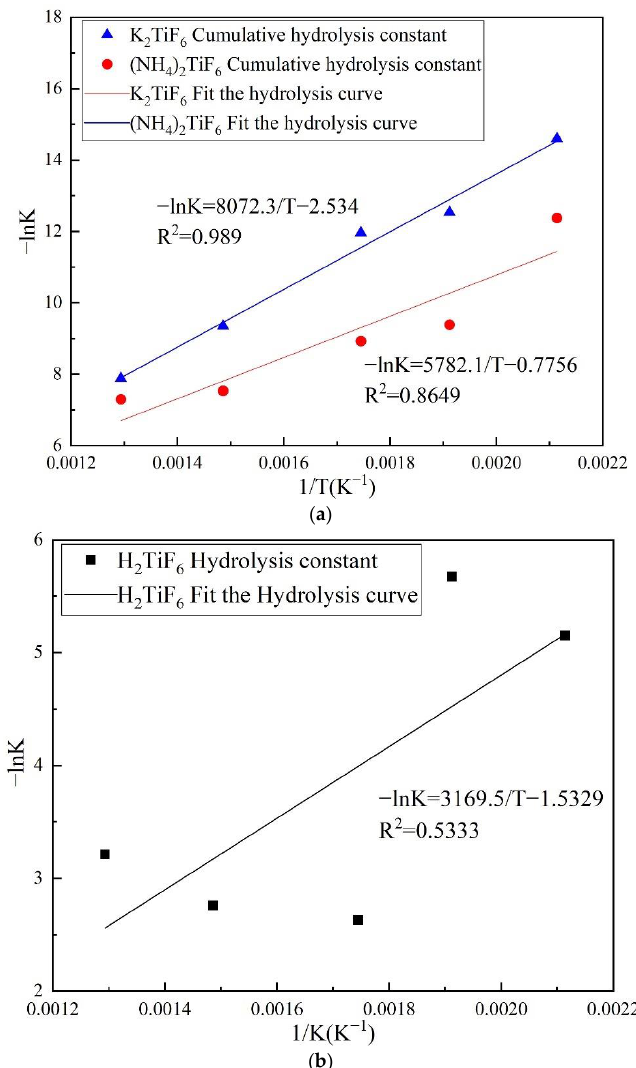
Figure 2. ( a ) Fitting curve ((NH 4 ) 2 TiF 6 and H 2 TiF 6 ) between different F-Ti complexes apparent hydrolysis constant and temperature. ( b ) Fitting curve (H 2 TiF 6 ) between different F-Ti complexes apparent hydrolysis constant and temperature.